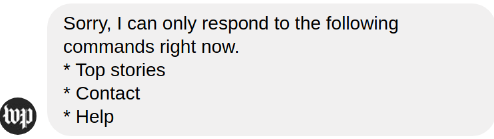
Fig. 22. Washington Post chatbot’s reply when it cannot understand the user’s utterance. Beta chatbot was found to use only one strategy: S3 (Sug- gesting next actions to the user). Beta is structured as a scripted conversation, the chatbot sends a message that ends with a question and it shows two quick replies as possible answers.